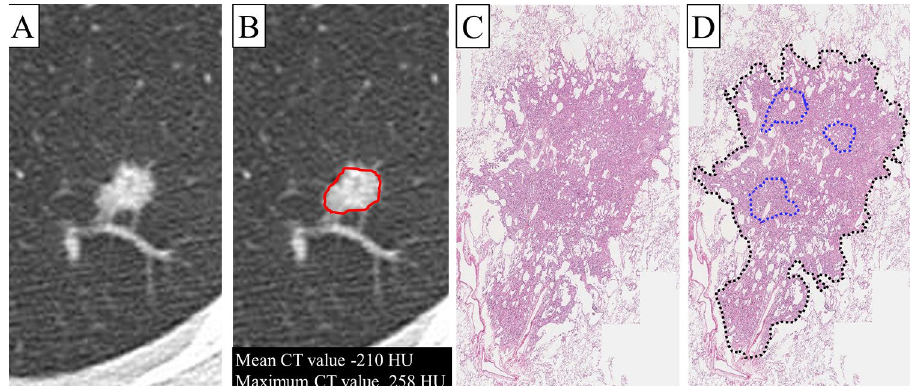
Figure 1. Representative case of a small lung adenocarcinoma presenting as solid nodule. ( A ) Axial CT image showing a solid nodule. ( B ) The region of interest (ROI) was manually placed using AZE Virtual Place software. ( C ) This lesion revealed lepidic predominant histology. ( D ) Three acinar components were observed in the central area (marked by blue dots), and a lepidic component was seen surrounding the acinar